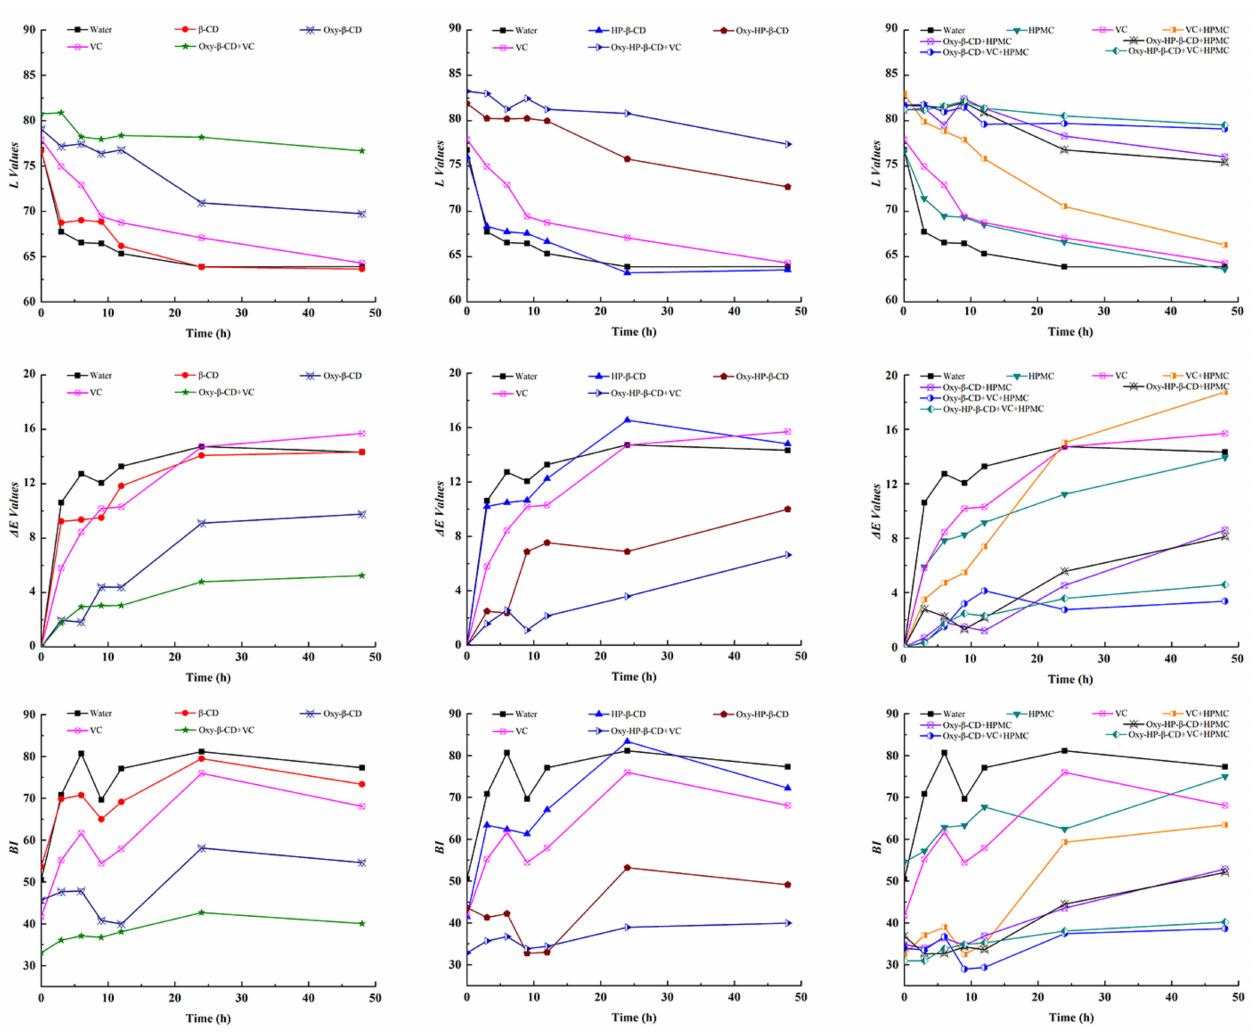
Figure 11. Reflectance measurement of L, ∆ E values, and BI of apple slices soaked in different solutions and stored at room temperature for 48